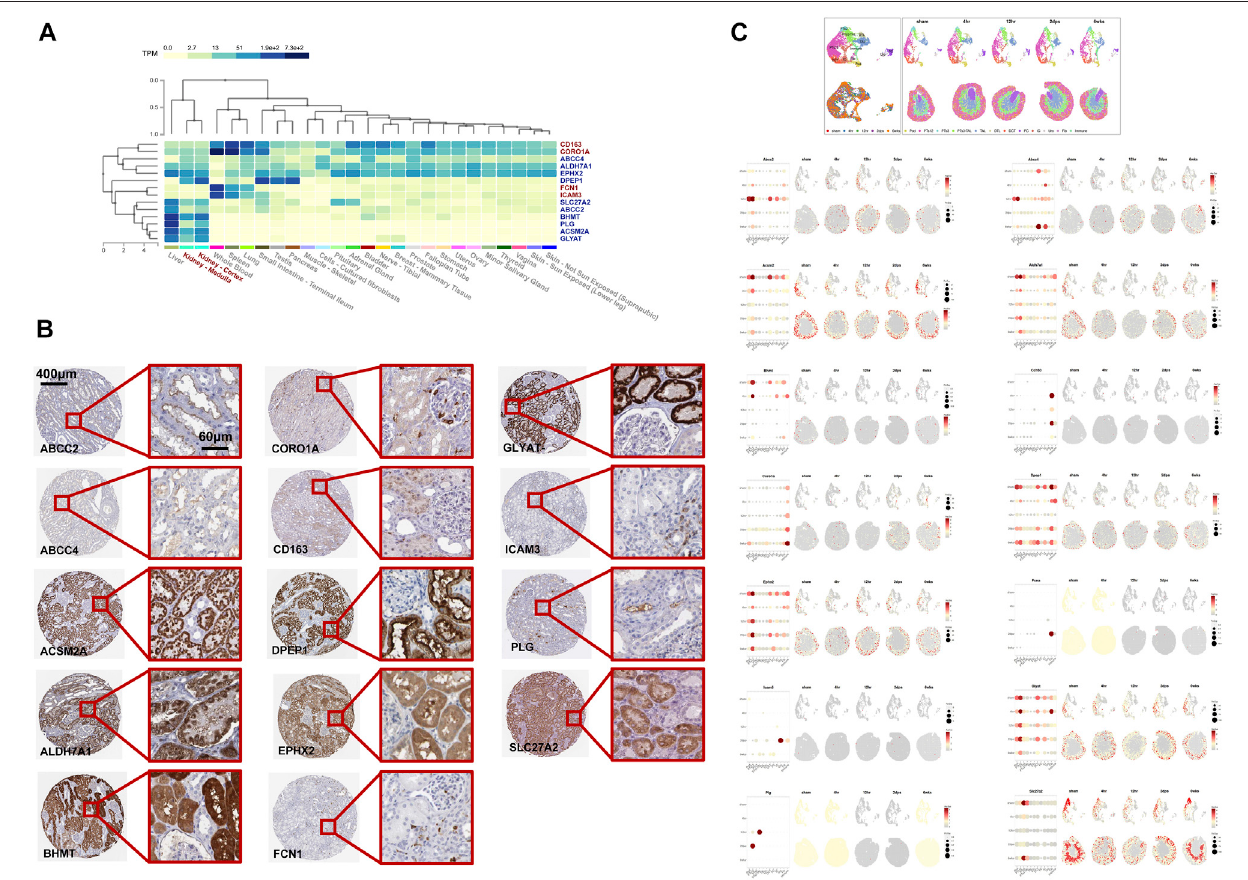
FIGURE 8| Space-validation ofRFRGs based on The Human Protein Atlas Database and space-time dual-validation ofRFRGs based on the Dixon 2021 scRNA- Seq database. (A) Transcriptional distribution of RFRGs in different organs based on datasets in the GTEx database. (B) Immunohistochemical staining of RFRGs depicted speci fi c translational distribution in renal tissue based on The Human Protein Atlas Database. (C) UMAPs of cell type clustering and spatial plots of increased resolution for major cell types. Spatial expression of RFRGs along the female injury time course. Pod, podocytes. PTs12, proximal tubule segments 1 – 2. PTs3, proximal tubule segments 3. TAL, thick ascending limb. DTL, descending thin limp of loop of Henle. DCT, distal convoluted tubule. PC, principal cells. IC, intercalated cells. Uro, urothelium. Fib, fi broblasts.